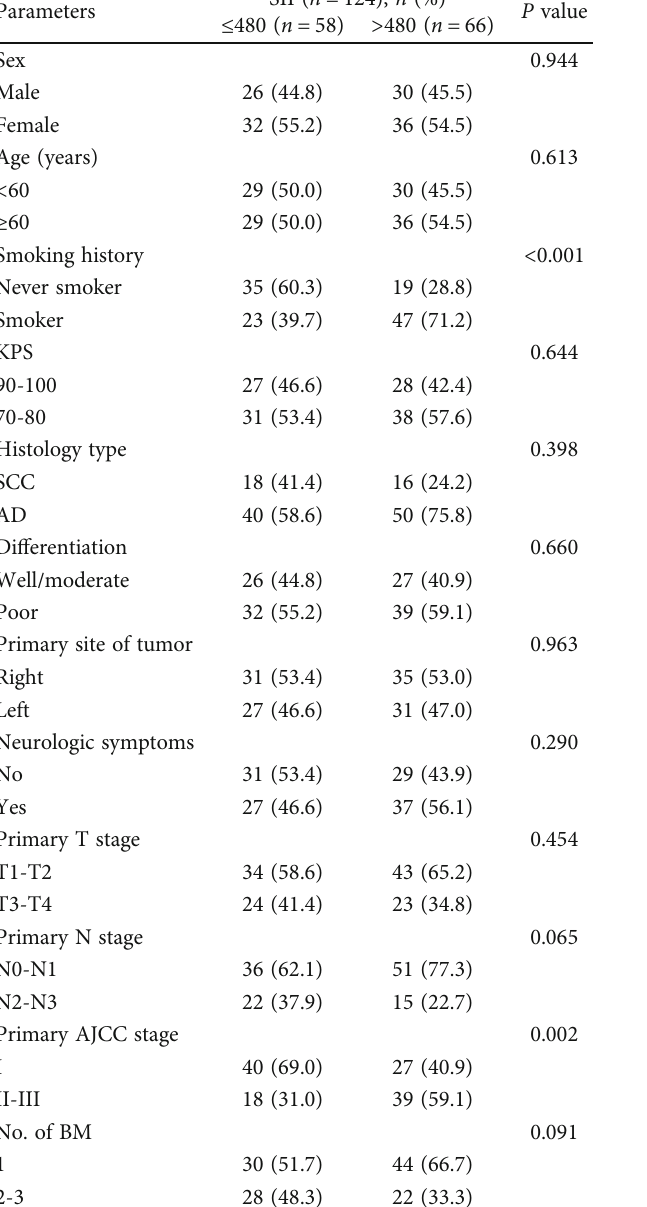
Table 2: The clinicopathological characteristics of NSCLC patients according to SII status.